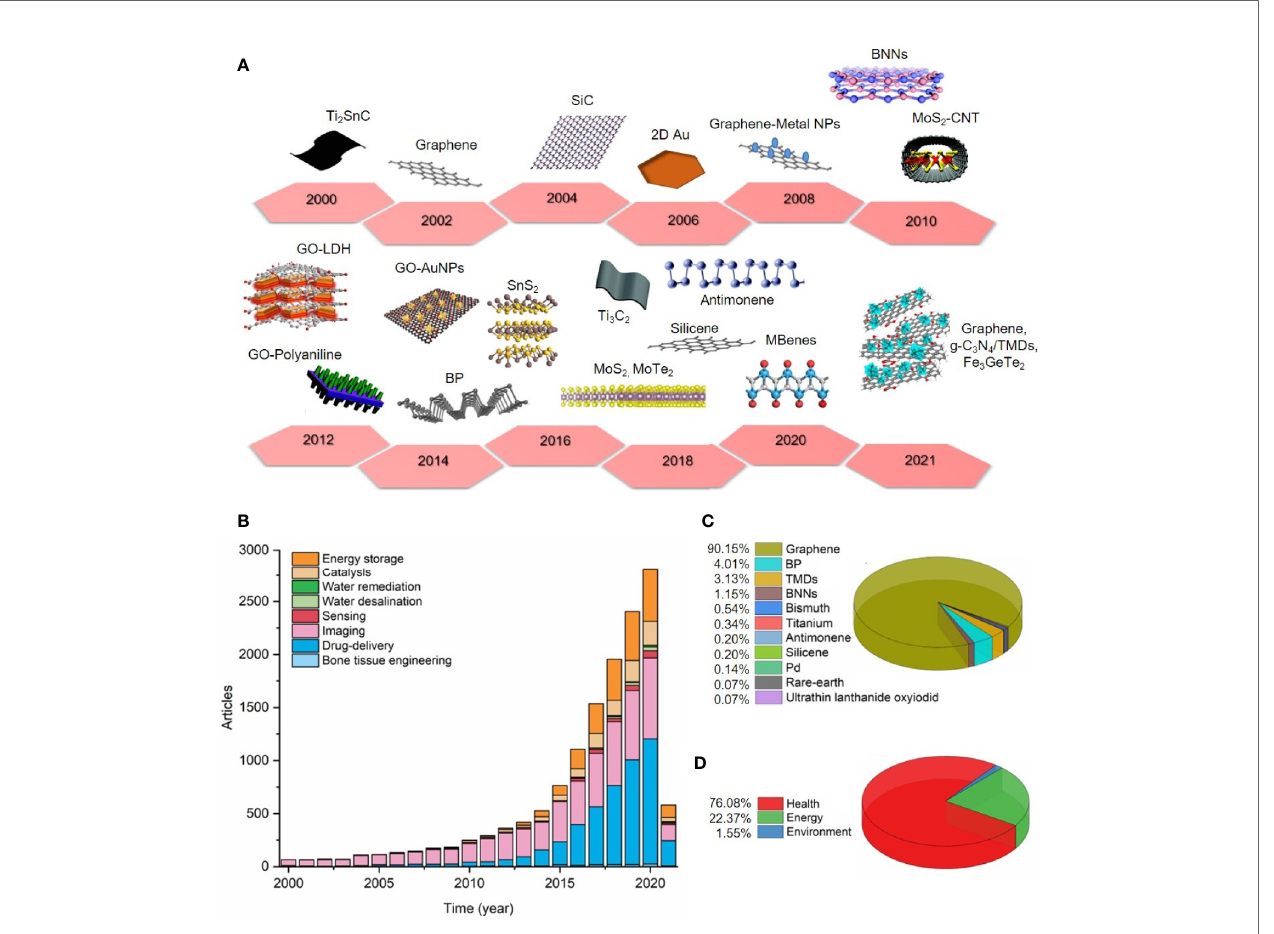
FIGURE 2 | The data obtained previously was organized into the following sectors: health (bone tissue engineering, drug delivery, imaging, sensing blood markers), energy (catalysis and energy storage), and environment (water remediation and desalination, and water sensing contaminants). (A) Timeline showing examples of 2D materials produced over the period established (from 2000 to 2021). (B) Number of articles from 2000 to 2021 (25/03/2021) (C) 2D materials used in nano-imaging applications (see supporting information) (D) Percentage of 2D materials applied in health, energy and environment